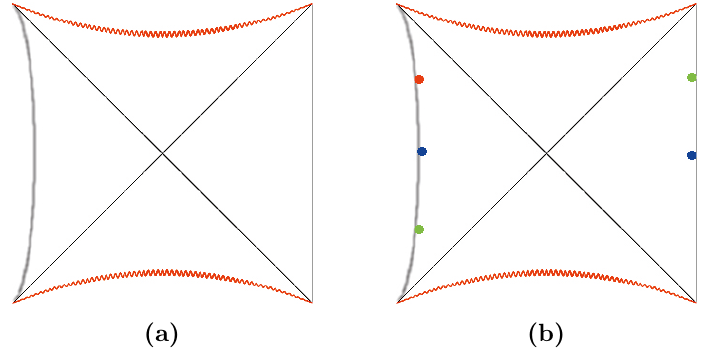
Figure 2. a) Penrose diagram of the typical black hole. b) Blue dots denote entangled operators, and green dots denote entangled operators at a later time, similar to the eternal black hole. However, someone using the state at the later time as the reference state for the mirror operator construction would place the location of the operator that is entangled with the right green operator at the red dot, thereby making the construction